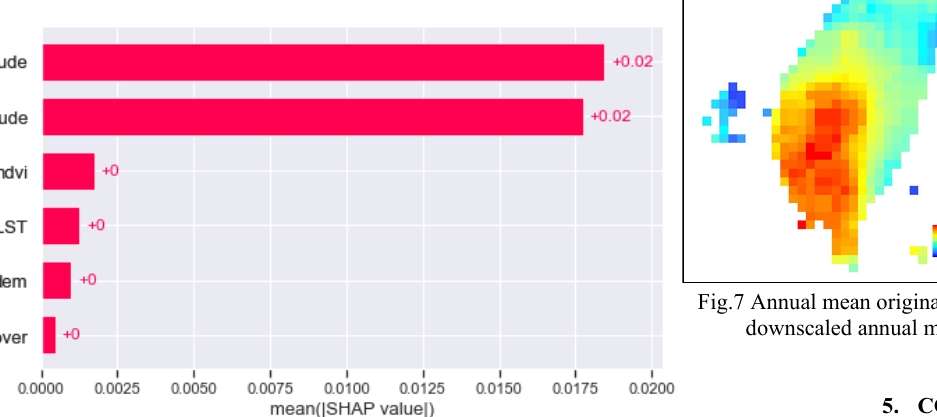
Fig.4 Summary plot of the SHAP values on downscaling model